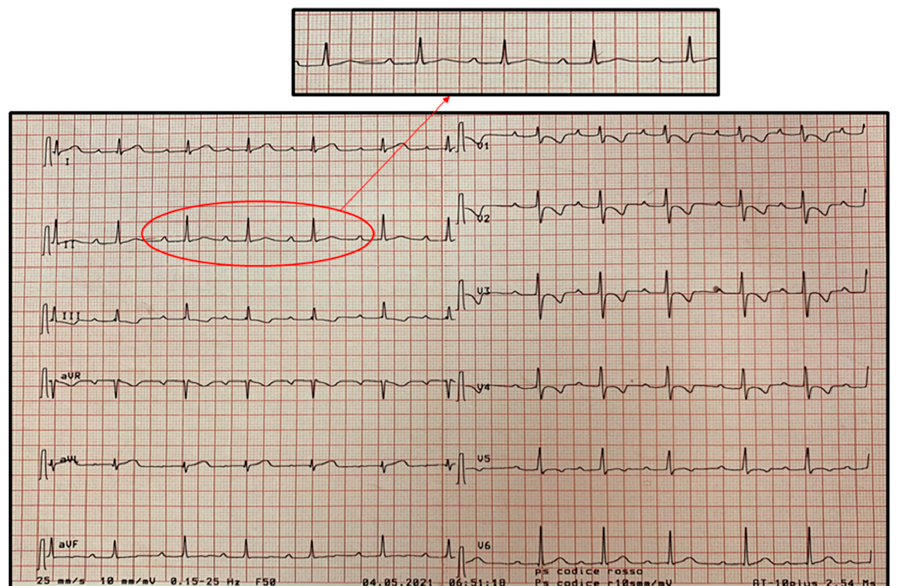
Figure 5. Sinus rhythm with first-degree atrioventricular block (AVB) in progress of MIS-C associated with coronavirus disease 2019 (COVID-19). First-degree AVB is a delay, without interruption, in conduction from atria to ventricles resulting in an increased PR interval greater than 200 ms.